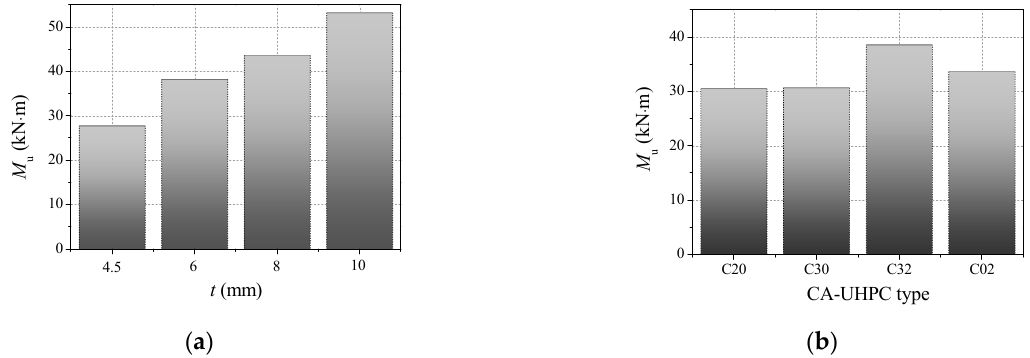
Figure 10. Ultimate flexural capacity of CA-UHPCFST beams. ( a ) The effect of steel tube thickness; ( b ) the effect of CA-UHPC type.